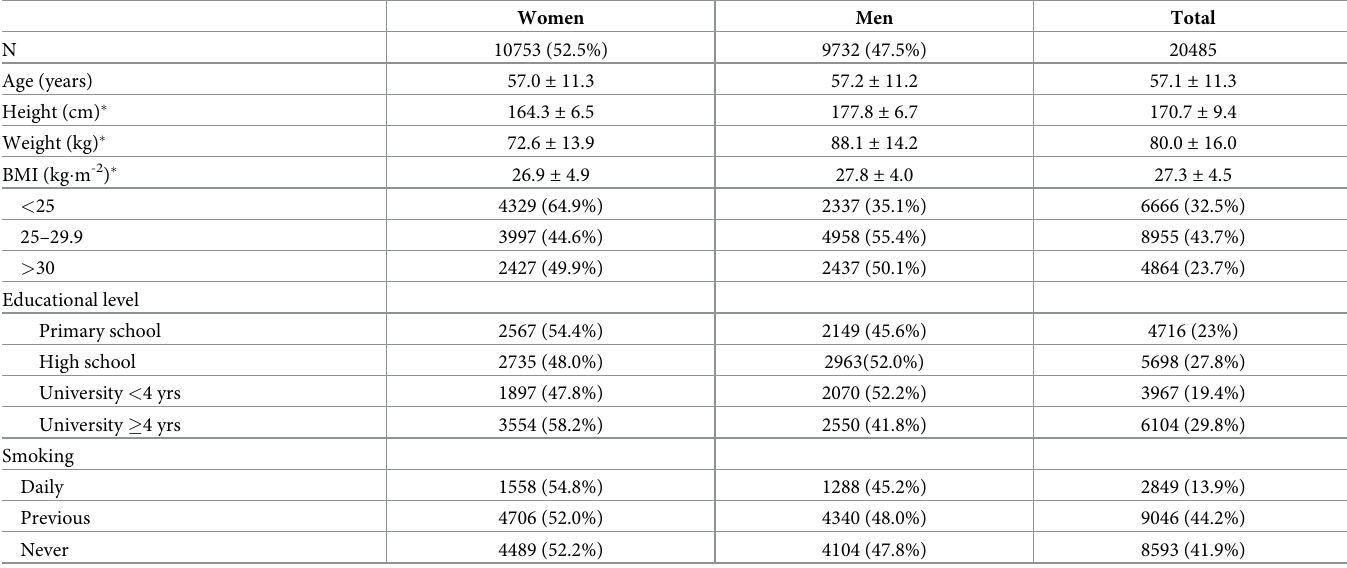
Table 1. Participant characteristics. The Troms ø Study total sample 2015–16.